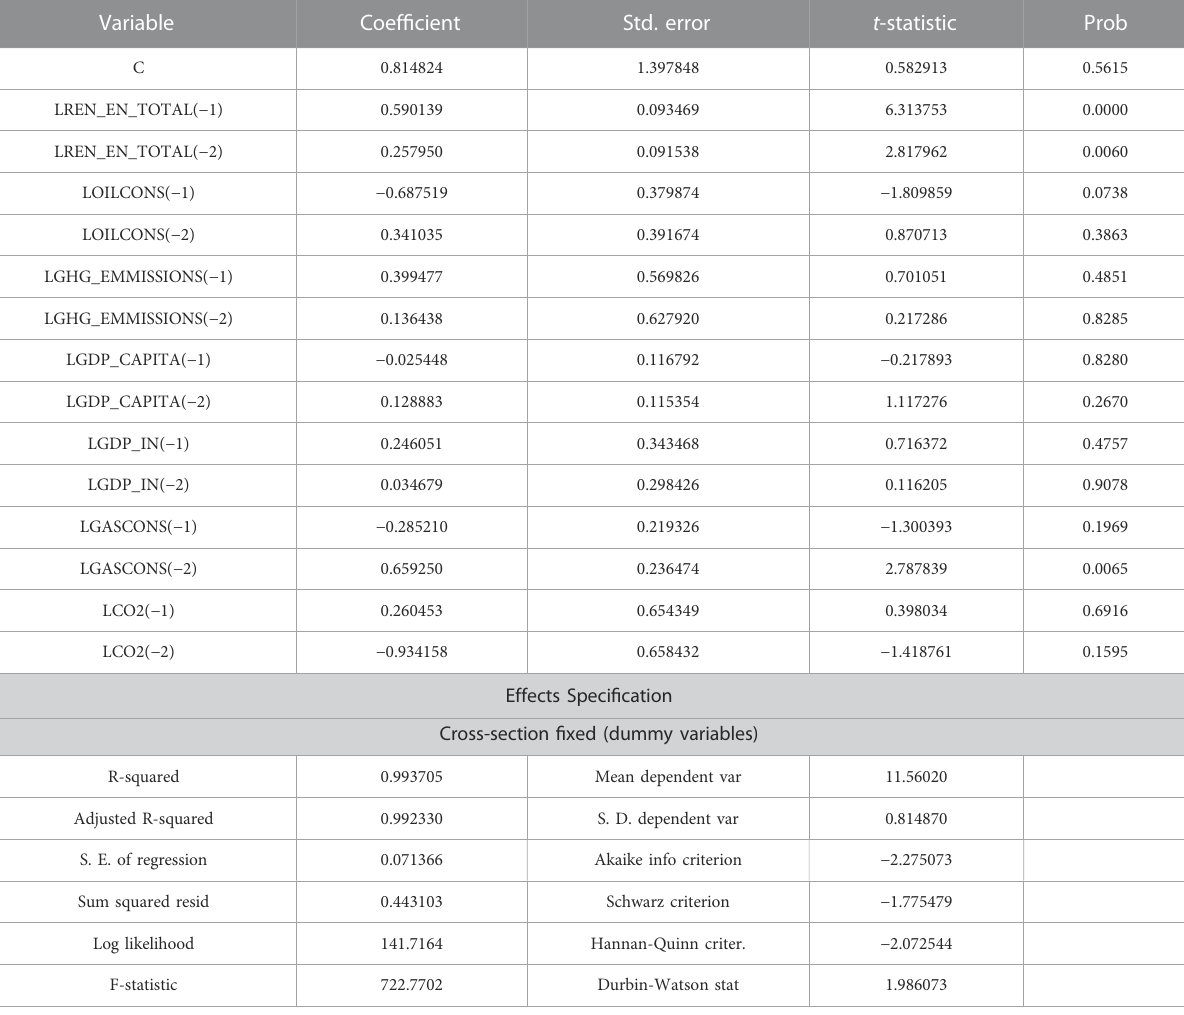
TABLE 6 Panel data analysis by using fi xed effects model — Panel Least Squares method, and renewable energy production capacity as dependent variable for G7.